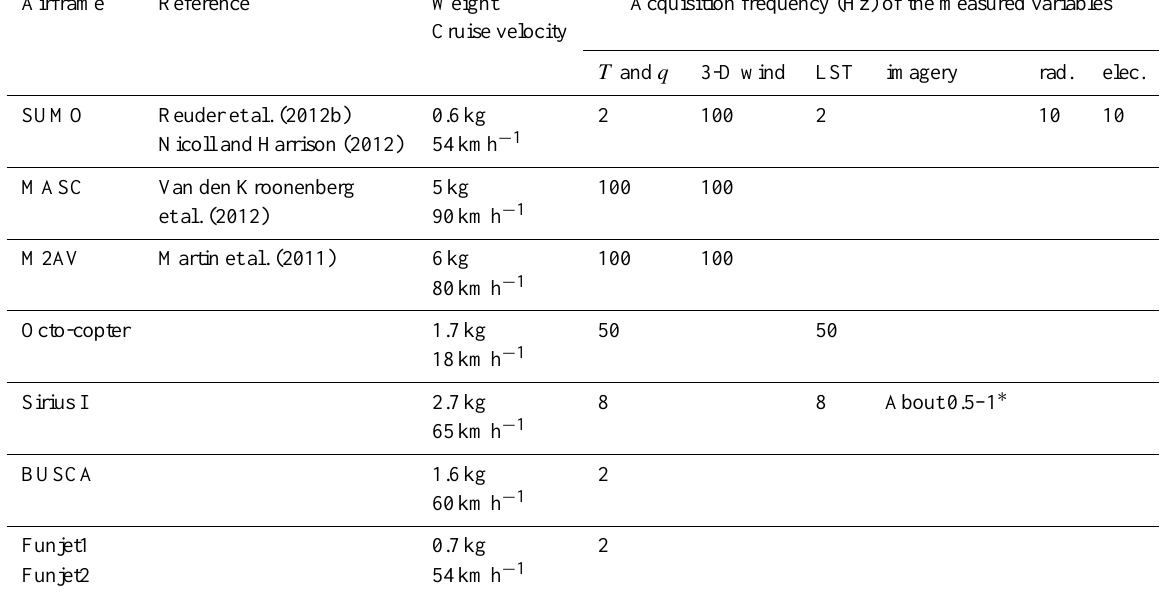
Table A5. RPAS which participated in the BLLAST field experiment. RPAS Weight, cruise velocity and measured variables are indicated. T , q , LST, Imagery, rad. and elec. stand for air temperature ( ◦ C), specific humidity (g kg − 1 ), land surface temperature ( ◦ C), downward short-wave radiation (W m − 2 ), and electric charges, respectively. Note that the RPAS Syrius Busca, Funjet1 and Funjet2 do not appear in Table 2, as they did not fly during IOP